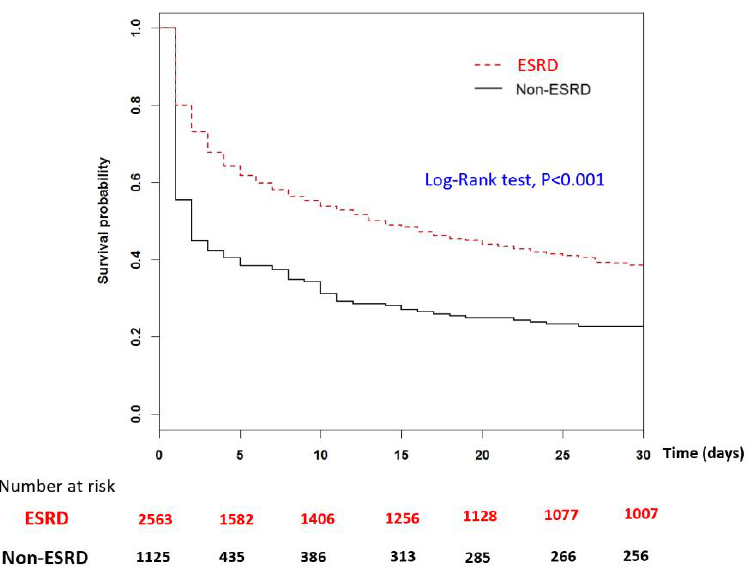
Figure 3. Kaplan-Meier analysis with log-rank test to measure the 30-day hospital survival rate post ROSC between the matched ESRD in regular dialysis and non-ESRD patients. X -axis displays the time in days. Y -axis displays the survival rate of admitted ROSC patients. p < 0.05 is the threshold for significance. ESRD: End-stage-renal-disease; ROSC: return of spontaneous circulation.